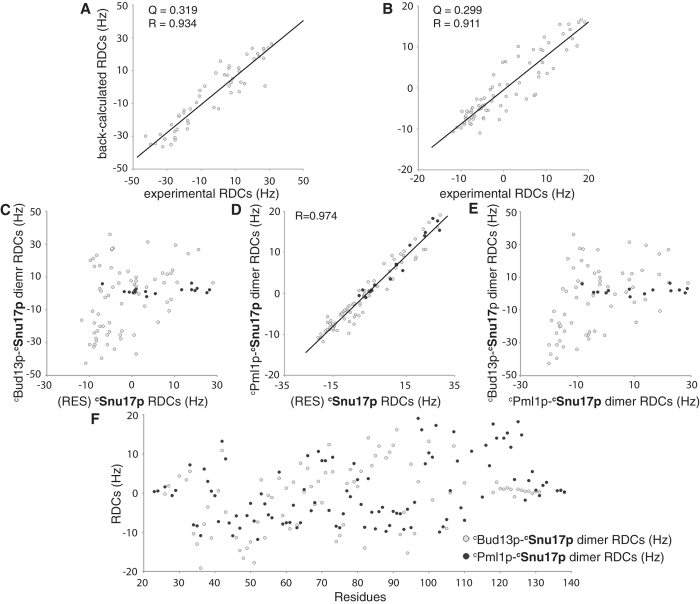
Analysis of HN RDCs observed in cSnu17p when part of the cPml1p–cSnu17p dimer, the hcBud13p–cSnu17p dimer and cRES.(A,B) Comparison of experimental RDCs with values back-calculated from the 3D structure of the cPml1p–cSnu17p dimer (A) and the hcBud13p–cSnu17p dimer (B). (C,D) Comparison of RDCs observed in cSnu17p in cRES with RDCs observed in cSnu17p when part of the hcBud13p–cSnu17p dimer (C) or the cPml1p–cSnu17p dimer (D). Black dots indicate disordered C-terminal residues in the hcBud13p–cSnu17p dimer. (E) Comparison of RDCs observed in cSnu17p in complex with cSnu17p and in complex with hcBud13p. Black dots indicated disordered C-terminal residues in hcBud13p–cSnu17p dimer. (F) Residue-specific comparison of RDCs observed in dimeric complexes of cSnu17p with cPml1p and with hcBud13p. In (F), RDC values of the hcBud13p–cSnu17p dimer were normalized to the magnitude of the alignment tensor of the cPml1p–cSnu17p dimer.